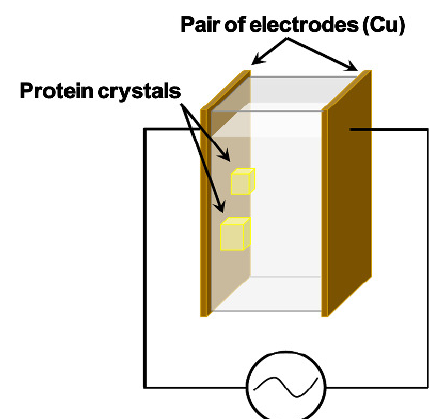
Figure 1. Schematic illustration of the batch arrangement with electrodes on both sides of a plastic cell. Reproduced from reference [18], with permission of the International Union of